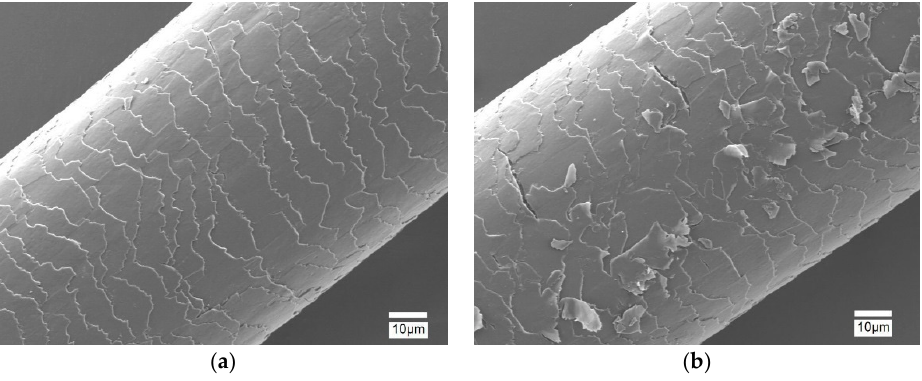
Figure 7. Cuticle morphology of the ( a ) protected and ( b ) unprotected virgin hair after six exposure cycles.